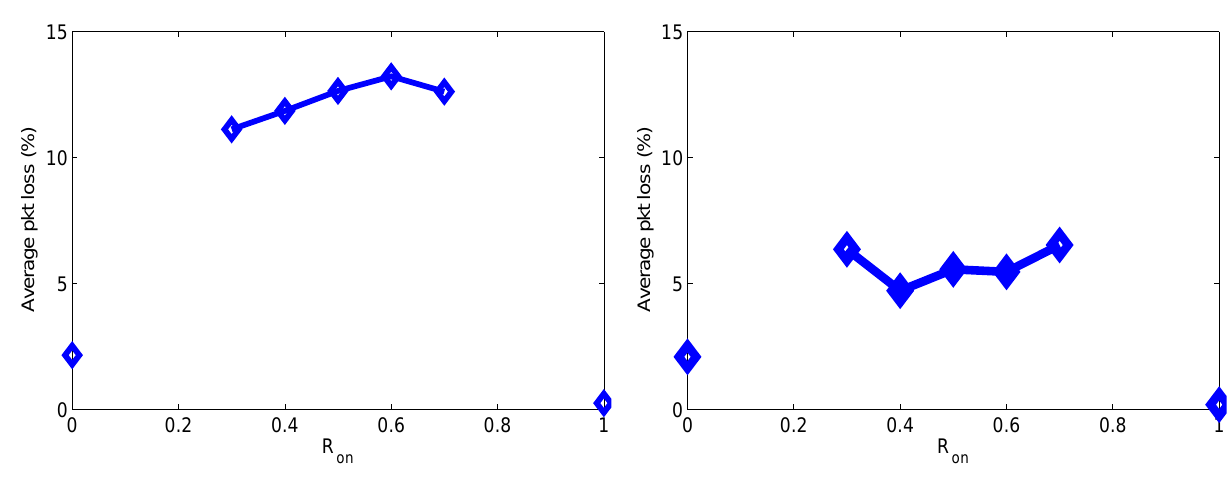
Figure 5. Network average packet loss versus average ON rate R T = 50 s . cycle